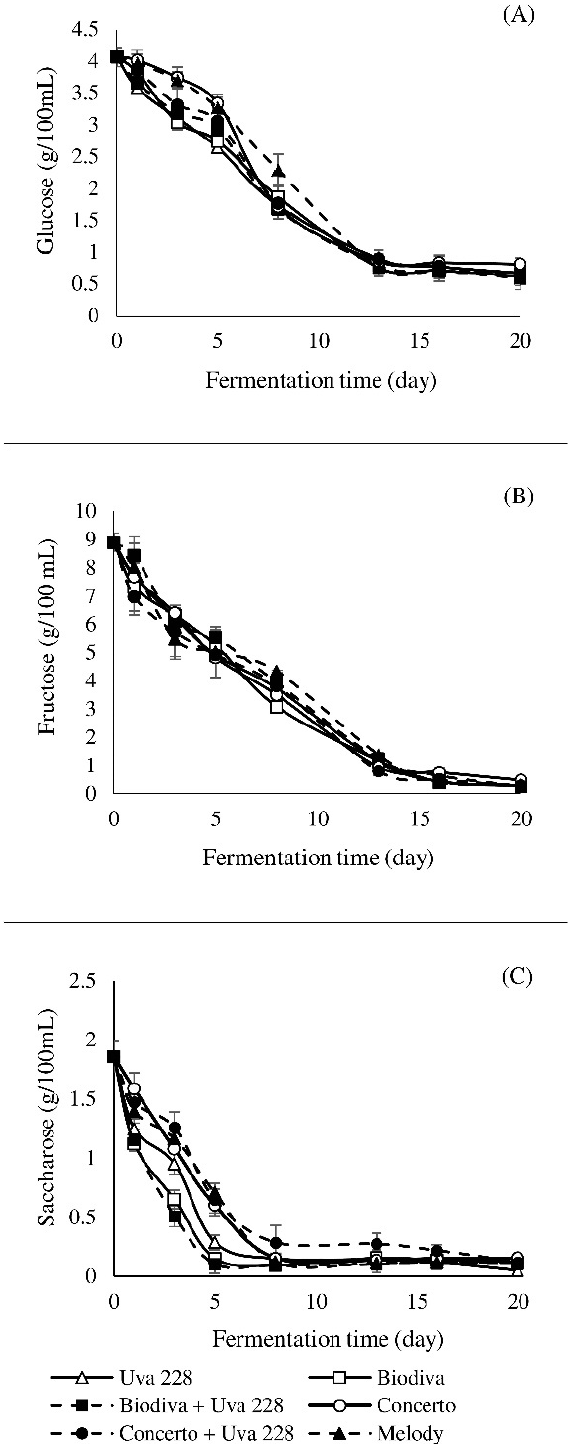
Figure 1. The concentrations of glucose ( A ), fructose ( B ), and saccharose ( C ) in apple mash during the fermentation process.